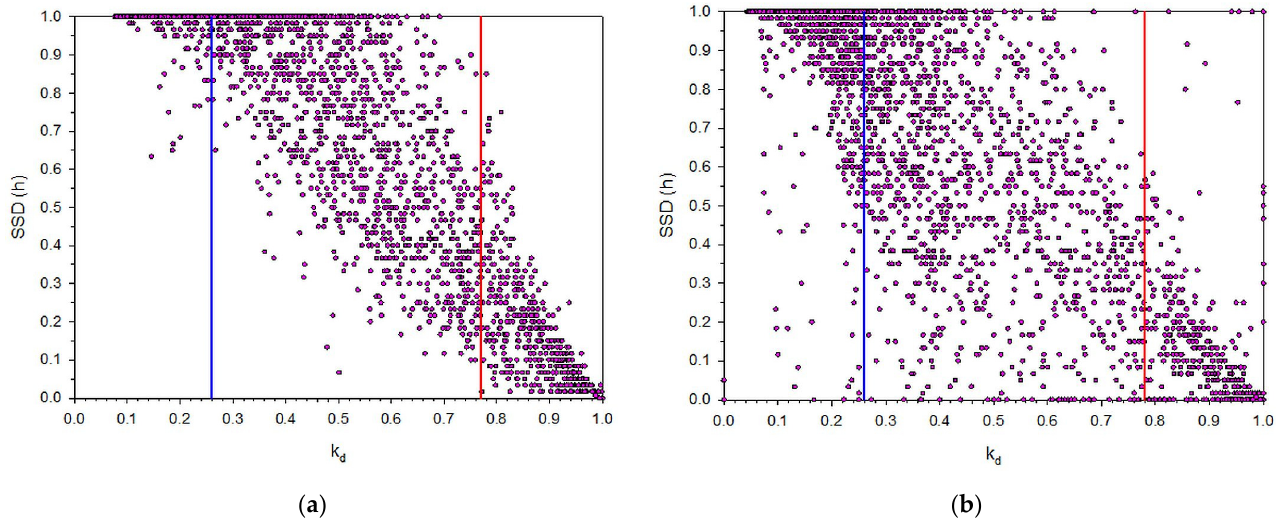
Figure 12. Determination of clear, intermediate, and overcast skies for the ( a ) CAR and ( b ) DAA sites.